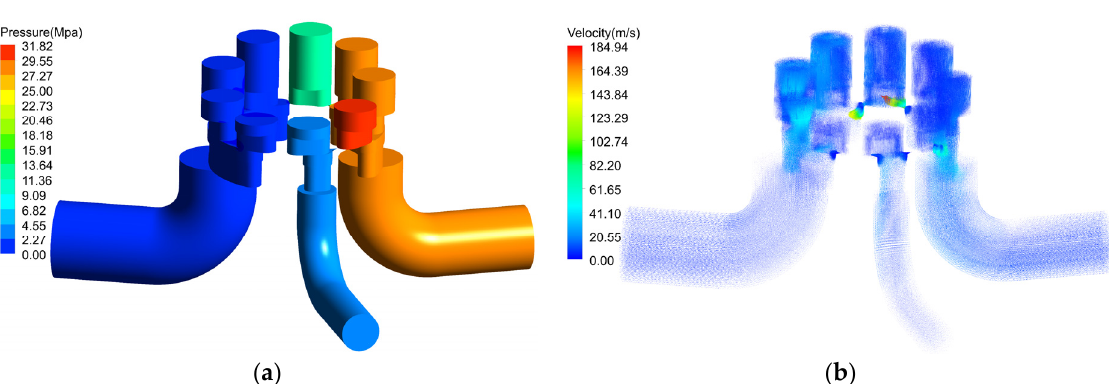
Figure 8. Pressure contours and velocity vector diagram at 20° rotation of the piston pump. ( a ) Pressure contours. ( b ) Velocity vector diagram.